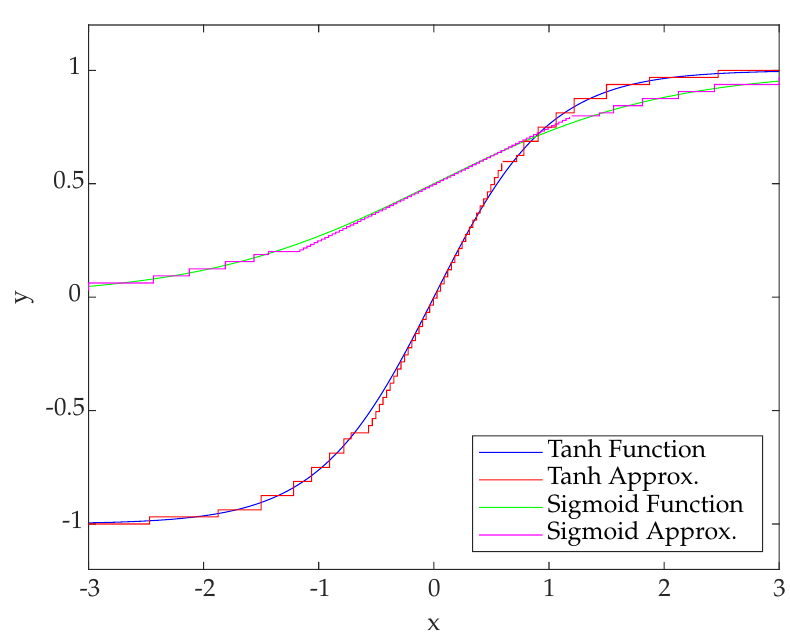
Figure 3. Plot of the mathematical hyperbolic tangent function ( blue ) and its hardware-implemented approximation ( red ), as well as the mathematical sigmoid function ( green ) with its approximation (magenta). Steps originate from the quantization (Q7) in the area of linearization, and from the